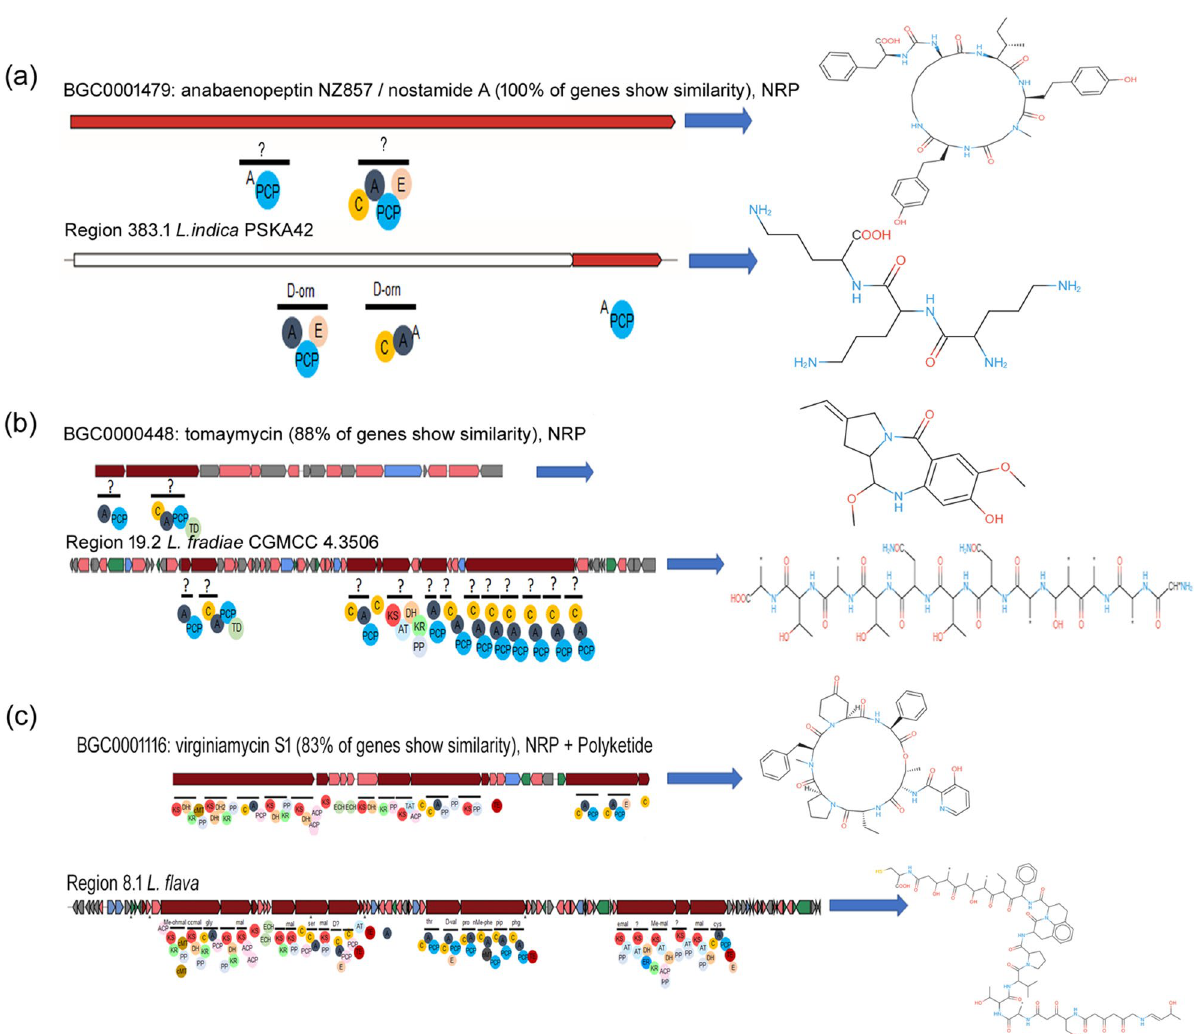
Figure 10. Species specific clusters and their putative products of Lentzea compared to the known clusters and their product from the antiSMASH database. ( a ) Biosynthetic cluster of anabaenopeptin NZ857/nostamide A of Nostoc punctiforme PCC 73102; ( b ) tomaymycin cluster of Streptomyces achromogenes compared with 88% similar genetic cluster of L. fradiae CGMCC 4.3506 and ( c ) genetic cluster for a macrolide group of antibiotics virginiamycin S1 of L. flava JCM 3296 having 83% similarity with that of Streptomyces virginiae of L. flaviverrucosa As40578. Some clusters show sequence similarity < 60% with the clusters of several prod- ucts like tallysomycin A (anticancer), showdomycin (potent nucleoside antibiotic), iso-migrastatin/migrastatin/ dorrigocin A/dorrigocin B/13-epi-dorrigocin A (inhibitors of tumor cell migration), candicidin (antifungal), pimaricin (antifungal) by the cluster of hybrids NRPS and T1PKS ( L. xinjiangensis CGMCC 4.3525), ectoine ( L. nigeriaca DSM 45680), transAT-PKS ( L. xinjiangensis CGMCC 4.3525), hybrid T1PKS, NRPS ( L. kentuckyensis NRRL B-24416), T1PKS ( L. indica PSKA42) (Fig. S7). Ribosomally synthesized and post‑translationally modified peptides (RiPPs). As previously